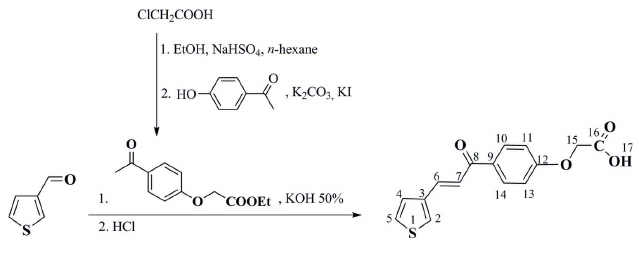
Figure 9 Reaction scheme for ( E )-2-{4-[3-(thiophen-3-yl)acryloyl]phenoxy}acetic acid.